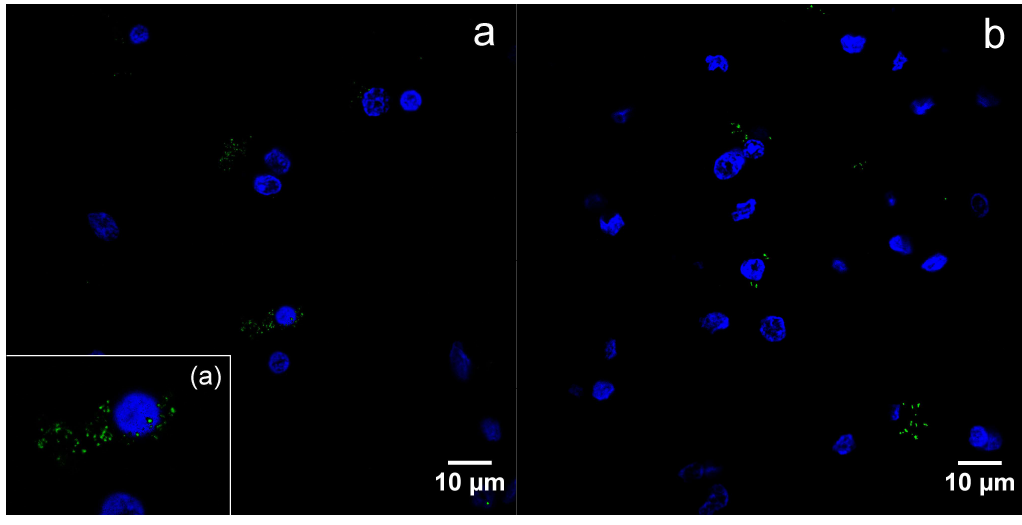
Figure 3. IHC: ( a ) B19V-positive oligodendrocytes (black arrows) and endotheliocytes (white 1 arrowheads) in the gray matter of the UEP subject (frontal lobe, 400 × ); ( b ) B19V-positive oligodendrocytes (black arrows), astrocytes (white arrows) and endotheliocyte (white arrowhead) in the white matter of the UEP subject (frontal lobe, 400 × ); ( c ) B19V-positive oligodendrocyte (black arrow) and astrocyte (white arrow) in the gray matter of the UEP subject (temporal lobe, 400 × ); ( d ) B19V-positive oligodendrocytes (black arrows), astrocytes (white arrows), endotheliocytes (white arrowhead) and erythrocytes (black arrowhead) in the white matter of the UEP subject (temporal lobe, 400 × ); ( e ) myelin basic protein (MBP) immunoexpression in the white matter of the UEP subject (frontal lobe, 400 × ); ( f ) MBP immunoexpression in the white matter of the UEP subject (temporal lobe, 400 × ).